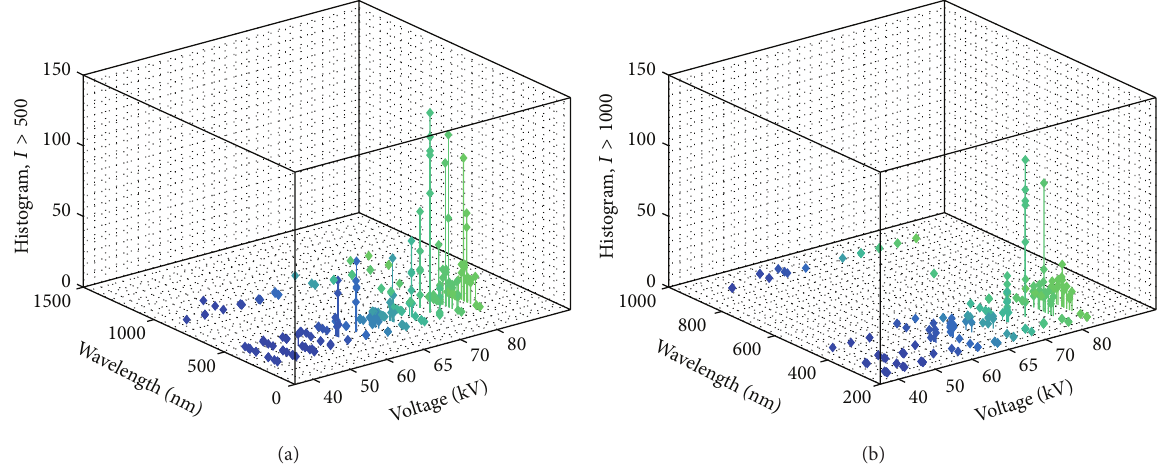
Figure 10: Summary of spectrum intensity histograms for different voltages: (a) 𝐼 > 500 and (b) 𝐼 > 1000